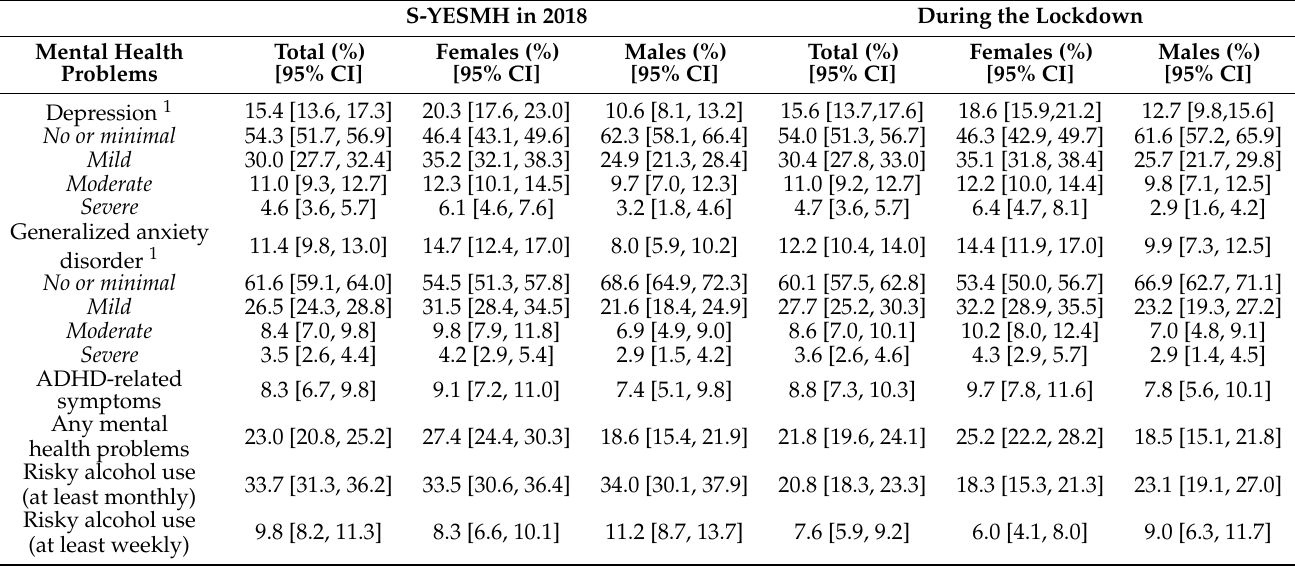
Table 3. Prevalence of mental health outcomes among young adults.